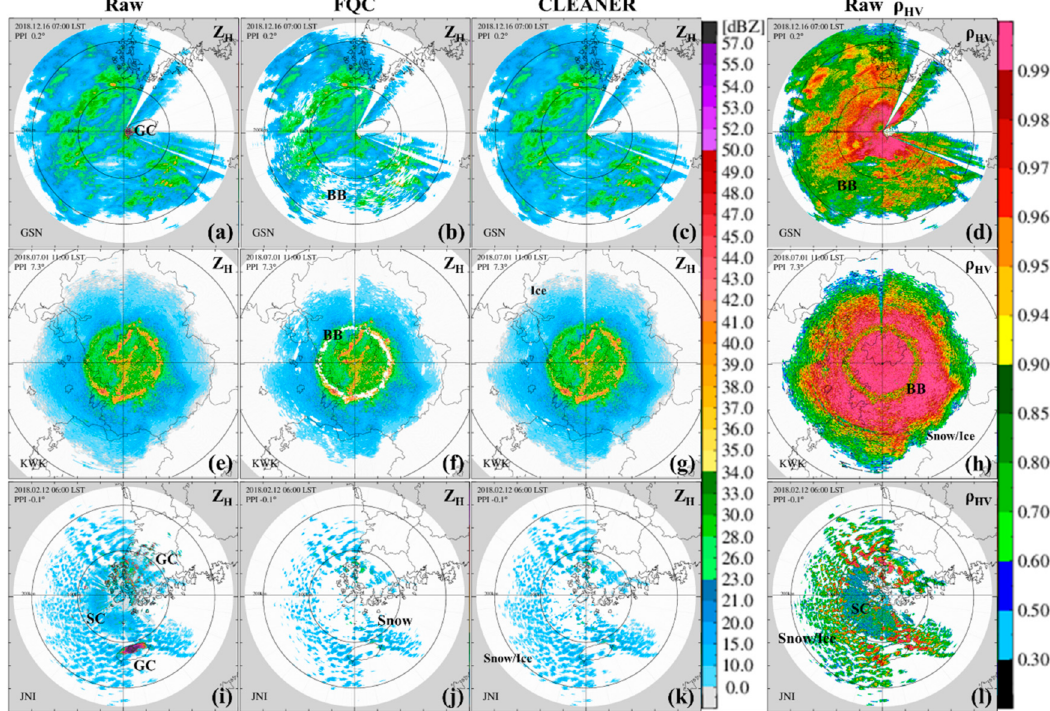
Figure 11. As in Figure 10, but with the correlation coe ffi cient field for two bright band cases collected ( a – d ) by GSN at an elevation angle of 0.2 ◦ at 0700 LST 16 December 2018 and ( e – h ) by KWK at an elevation angle of 7.3 ◦ at 1100 LST 1 July 2018 and ( i – l ) a snow case collected by JNI at an elevation angle of − 0.1 ◦ at 0600 LST 12 February